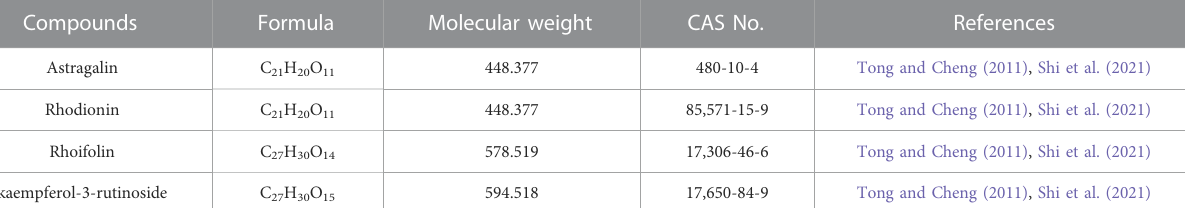
TABLE 4 The fl avonoids composition in ATR. Compounds Formula Molecular weight CAS